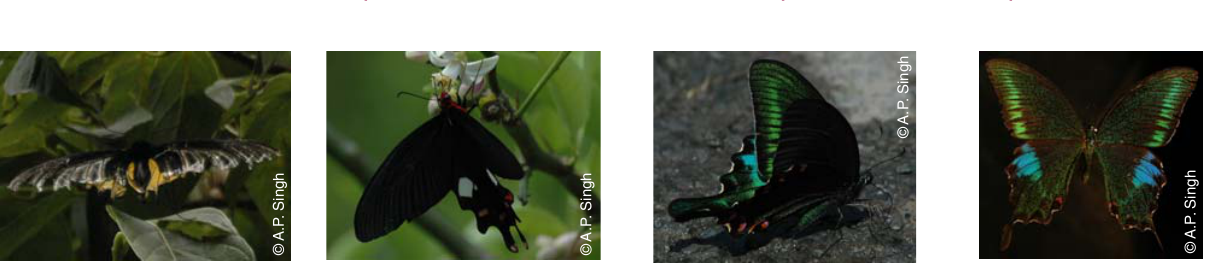
Image 112. Common Windmill, Atrophaneura polyeuctes